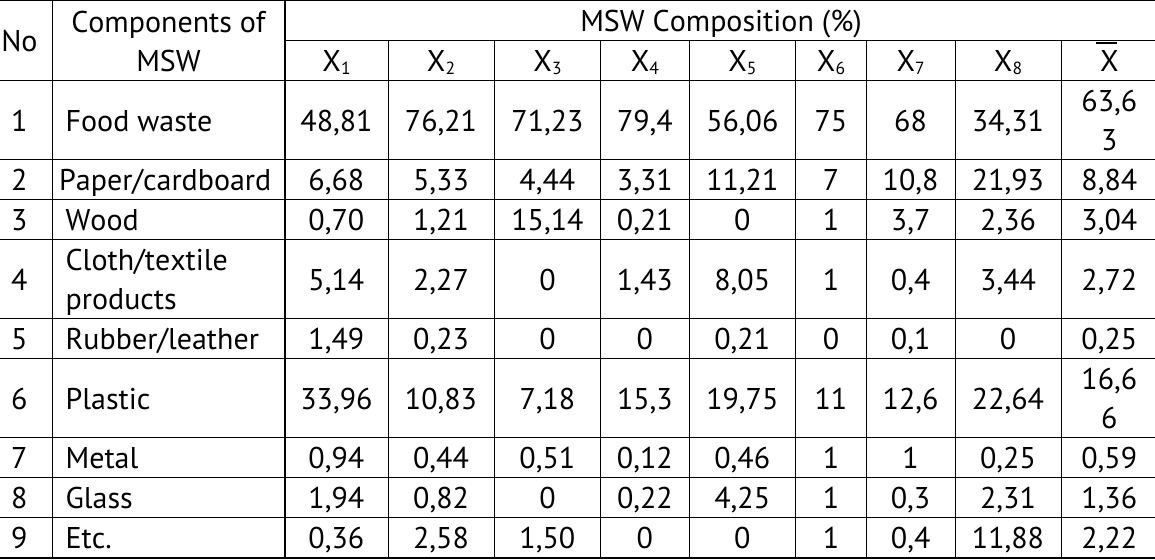
The Average of MSW